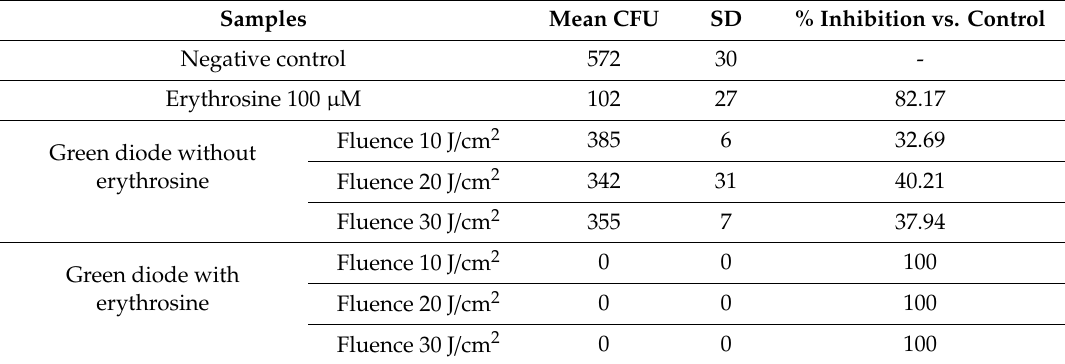
Blue diode with curcumin